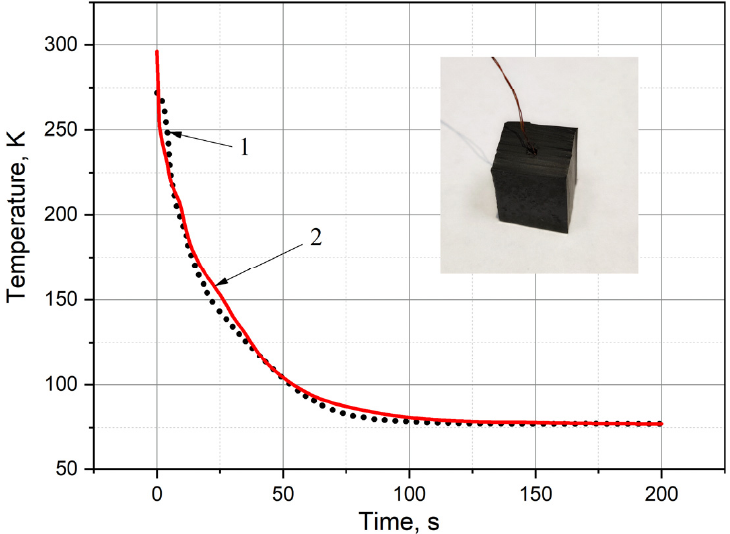
Figure 3. Comparison of the experimental and simulation data. 1—experiment, 2—model.